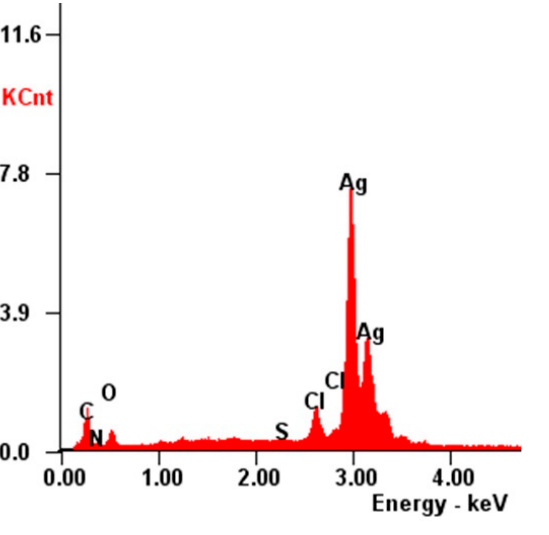
2 O ( a ) and of AgNPs-EtOH ( b ).